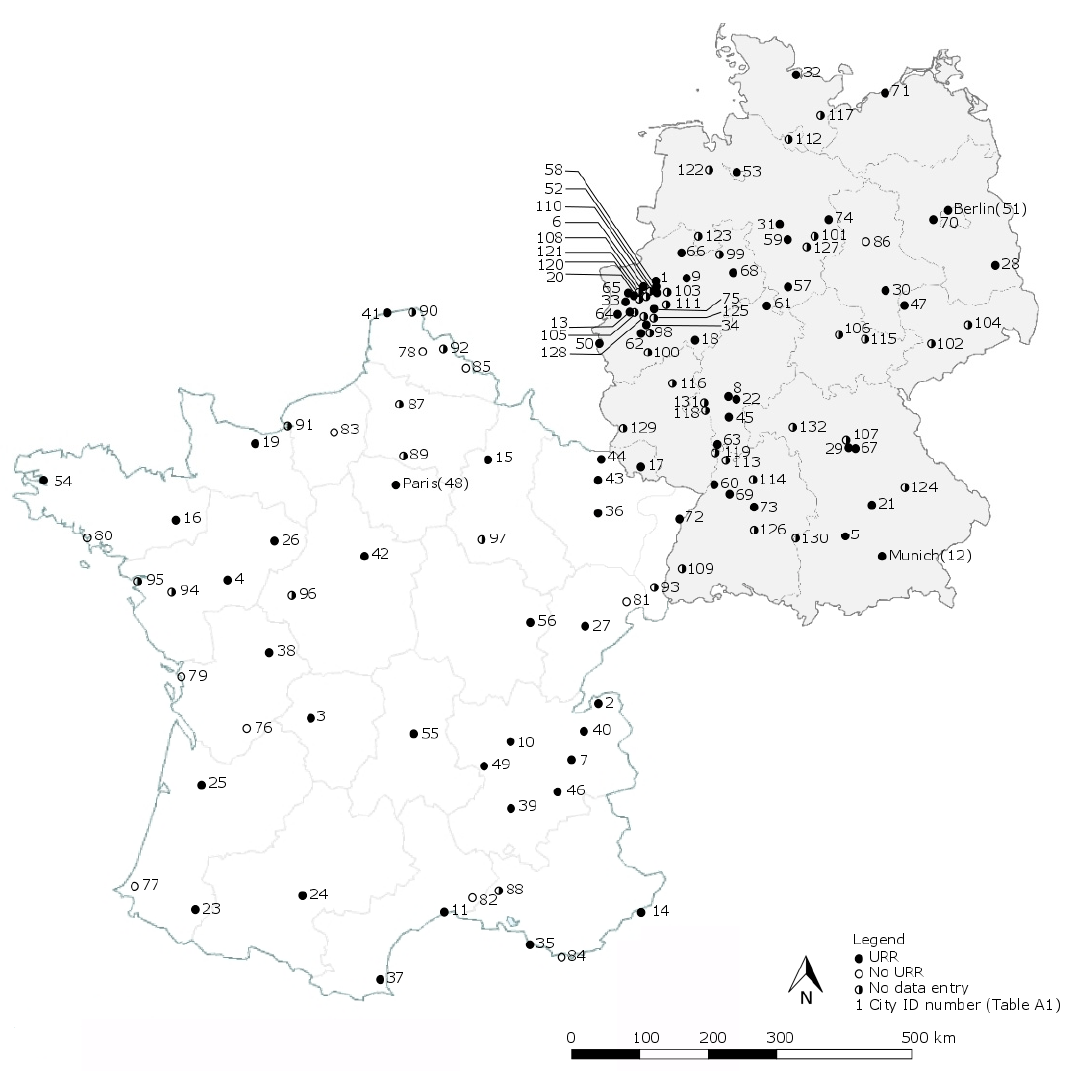
Figure 1. Map of the 75 urban river restorations (URR) in France and Germany, 11 urban areas without river restorations (no URR), and 46 urban areas without an entry.